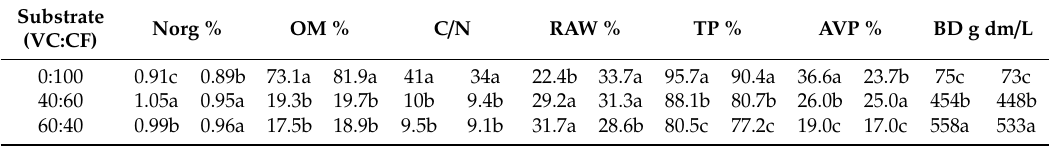
Table 2. Initial physicochemical properties (left column) and finals (right column) for each substrate mixture (% v : v , VC = vermicompost from horticultural crop waste, CF = coconut fibre).